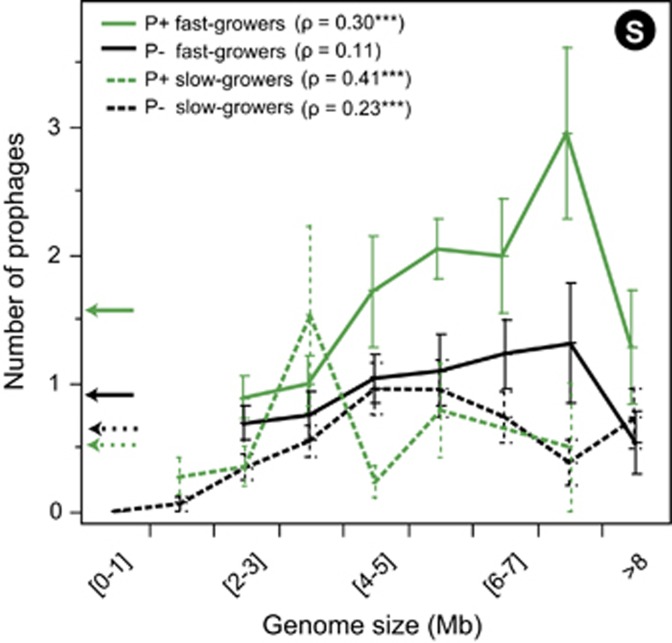
Distribution of the average number of prophages per bacterial genome in function of bacterial traits. The arrows on the left of the graph indicate the average number of prophages per genome (averaged across species) in each subset. The number of prophages per bacterial genome increases significantly with the host genome size in all cases (***P<10−4, the values of Spearman's ρ are reported for each analysis), except among non-pathogenic (P−) fast growers (Spearman's ρ=0.11, P>0.1).